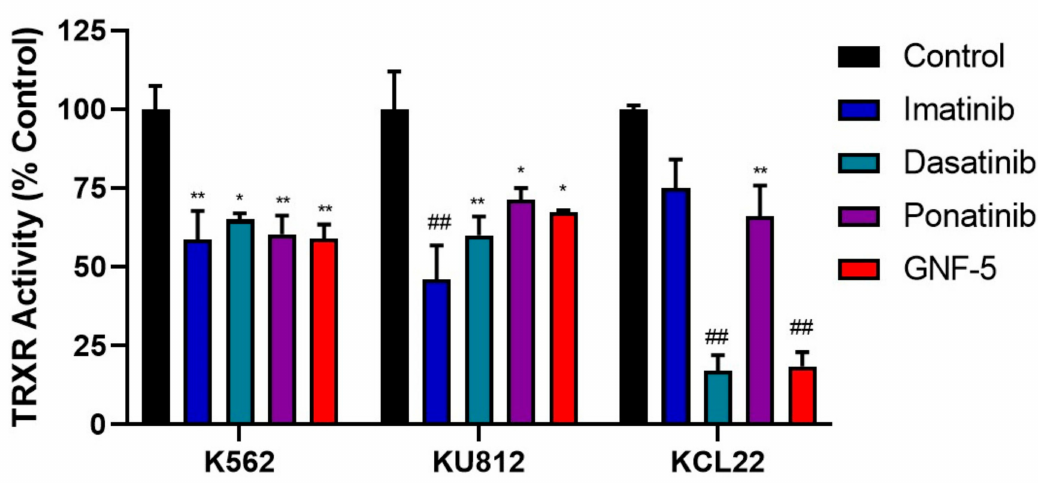
Figure 4. TKIs decrease TRXR activity in CML cells. K562, KU812 and KCL22 CML cells were treated with either imatinib, dasatinib, ponatinib or GNF-5 for 72 h followed by TRXR activity assays. K562 cells were treated with 0.5 µ M imatinib, 5 nM dasatinib, 10 nM ponatinib and 1 µ M GNF-5. KU812 cells were treated with 0.25 µ M imatinib, 1 nM dasatinib, 5 nM ponatinib and 1 µ M GNF-5. KCL22 cells were treated with 0.25 µ M imatinib, 5 nM dasatinib, 10 nM ponatinib and 0.5 µ M GNF-5. Results were analyzed via one-way ANOVAs with a Dunnett’s post hoc test. Statistical tests compared results between the treated cells and the untreated control for each cell line. * = p < 0.05, ** = p < 0.01, ## = p < 0.0001. n = 3. Values displayed as mean ±